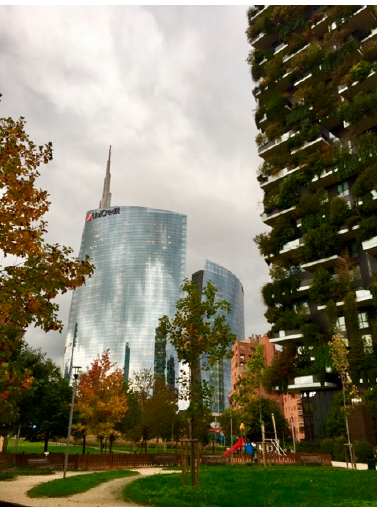
Figure 3. The new buildings of the regenerated area of “Porta Garibaldi” in Milan,